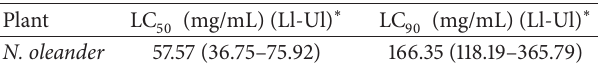
Table 2: Concentrations LC 50 and LC 90 lethal larvae of C. pipiens after 24 hours of